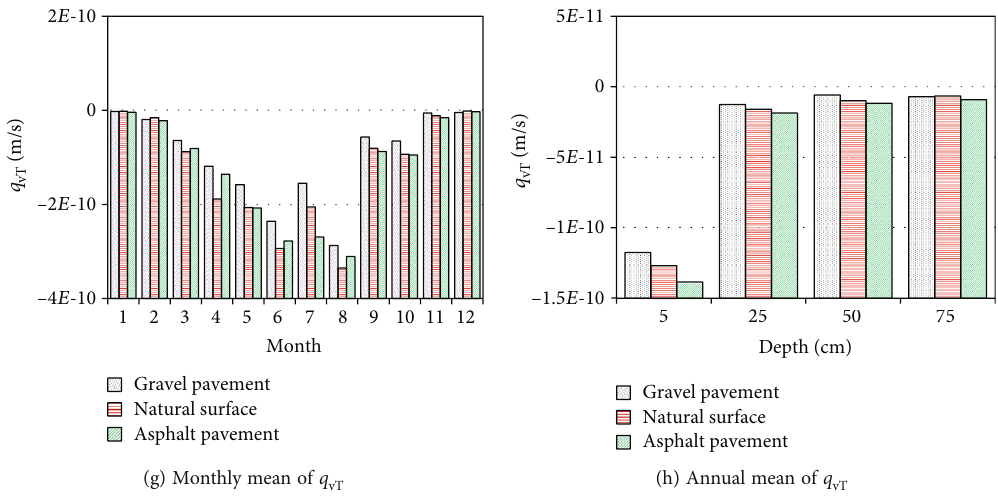
Figure 5: Soil water migration in di ff erent underlying surfaces.